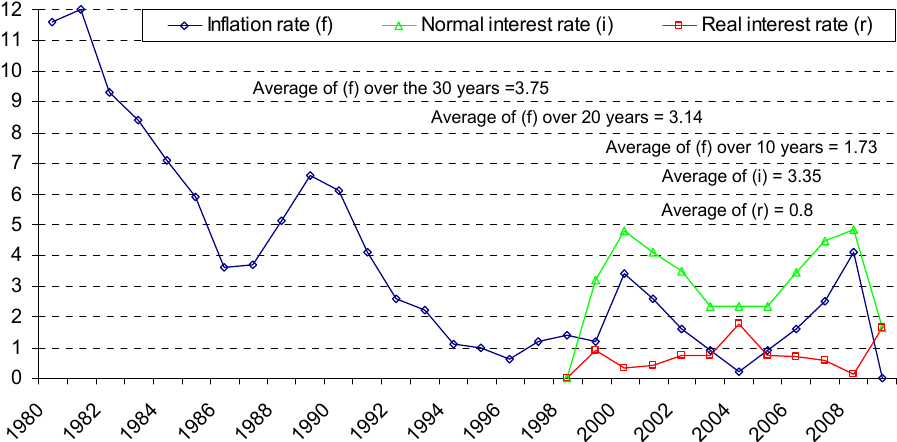
Figure 4. Year-on-year changes in the Consumer Price Index (inflation rate), normal interest rate, and real interest rate (%). These trends are taken from [60,61].